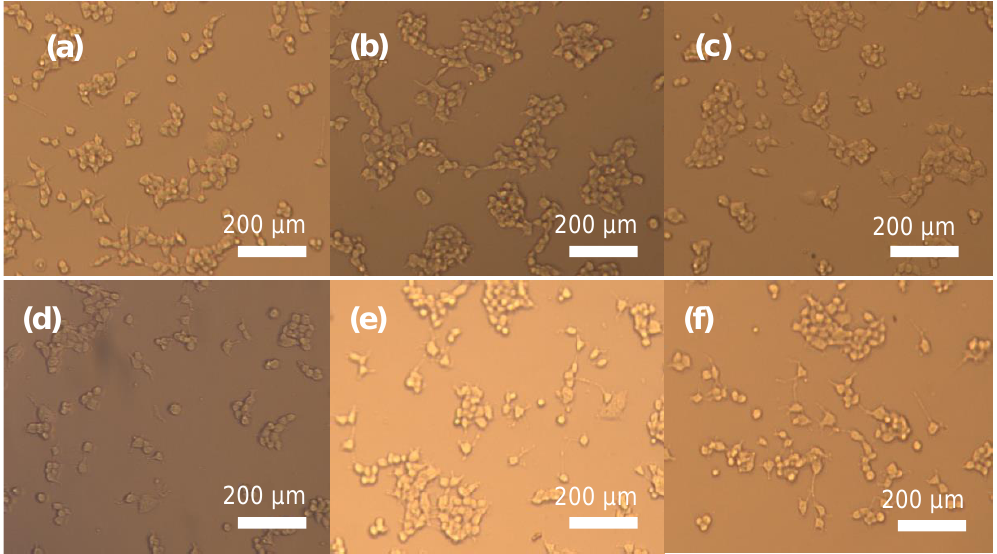
Figure 12. Optical microscope images of the MC3T3-E1 cells after incubation for 72 h in the presence of composite bioactive glass scaffolds containing ( a ) 0, ( b ) 0.1%, ( c ) 0.2%, ( d ) 0.5%, ( e ) 1%, and ( f ) 2% hBN nanopowders. Magnification at 100×.